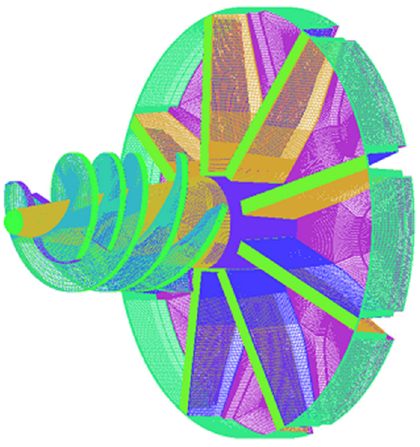
Figure 4. Local area grid of the inducer and the impeller.